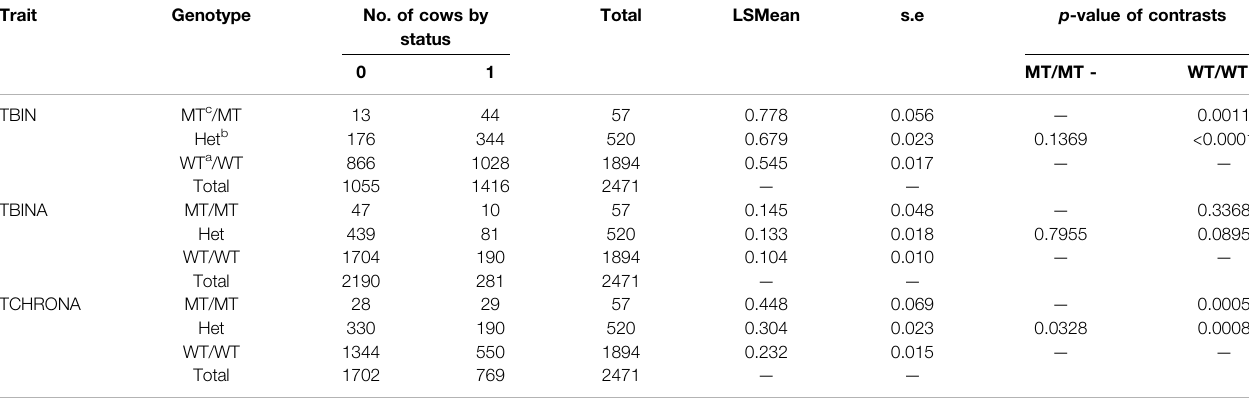
TABLE 3 | FRET analysis (Ensembl genome assembly ARS-UCD1.2) results of rs109521151 (BTA19). Analogous to Table 2 , the LSMEANs for the probability of being diseased according to trait de fi nitions TBIN, TBINA, and TCHRONA are given along with the number of animals in each sub-cell and the statistical contrasts between genotypes.